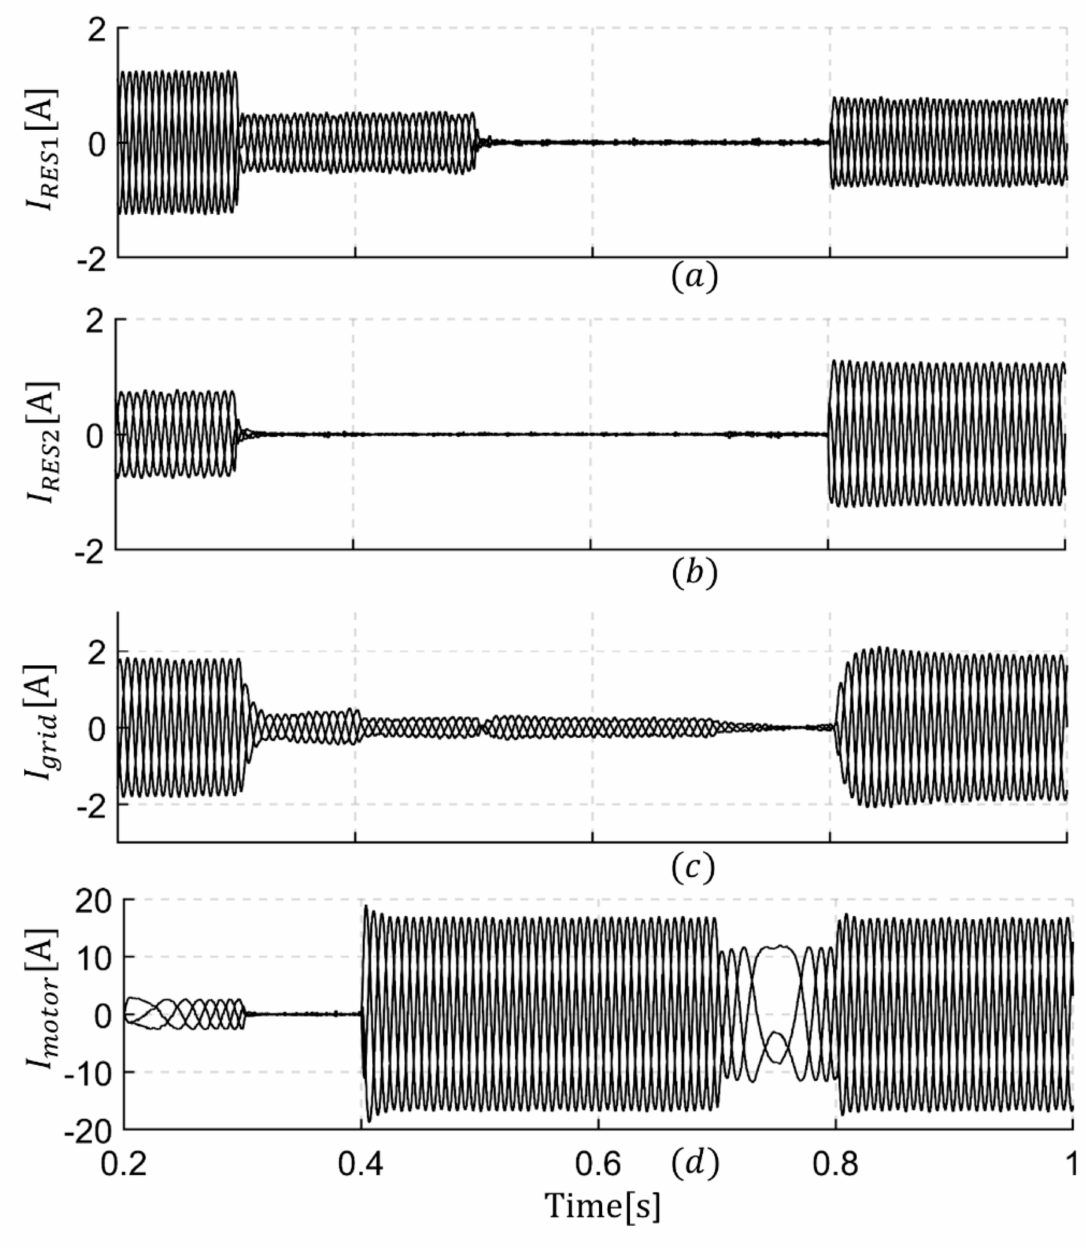
Figure 11. The responses of the ( a ) RES1 current, ( b ) RES2 current, ( c ) grid current, and ( d ) PMSM